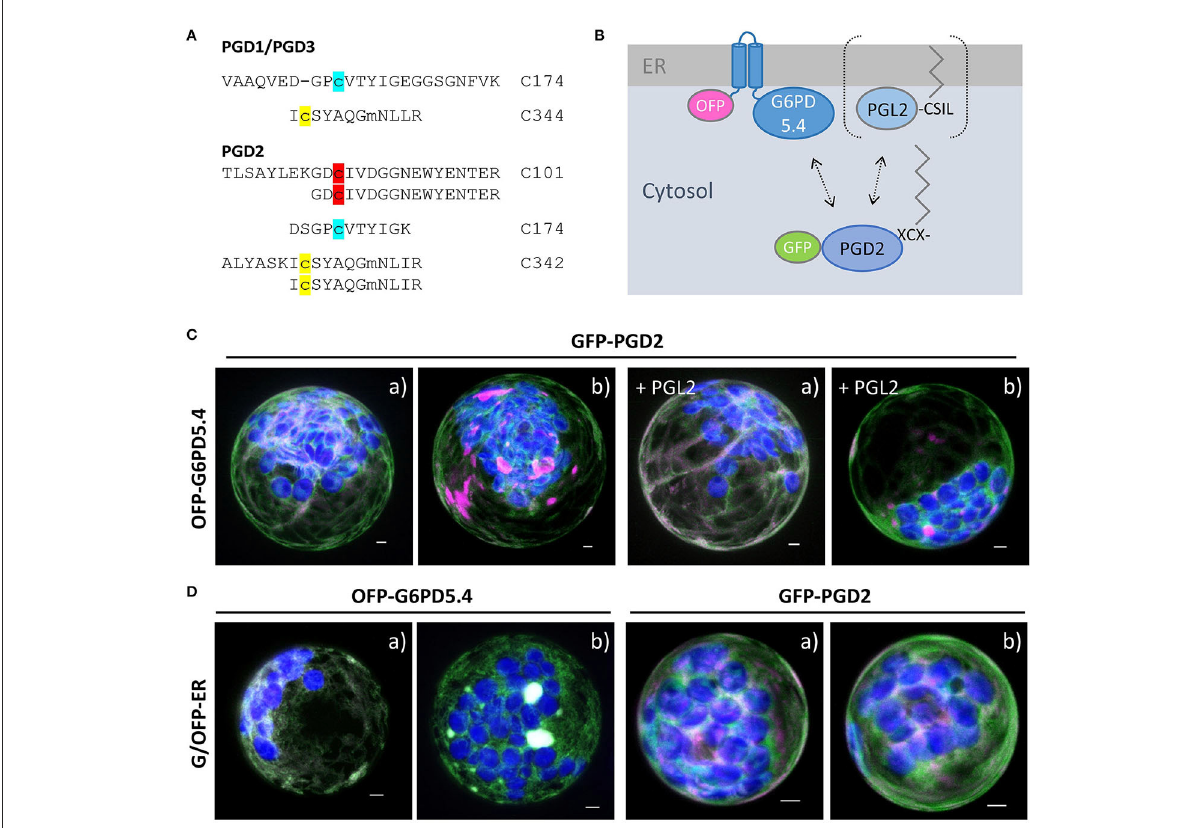
FIGURE7 Co-expression of OFP-G6PD5.4 and GFP-PGD2 without or with PGL2. 6-phosphogluconate dehydrogenase (PGD) is the second OPPP enzyme contributing to NADPH provision. (A) PGD peptides found in an Arabidopsis palmitoylome for PGD1/3 (cannot be discriminated) and PGD2 (Kumar et al., 2020). Cysteine positions shared by all PGD isoforms are labeled in yellow/blue, and the unique one of PGD2 in red. Among reporter fusions of the three PGD isoforms, PGD2 showed weak co-localization with PGL2 at the ER (Supplemental Figure S6). (B) To test whether PGL2 might function as a bridge between the two OPPP dehydrogenases, the GFP reporter was deleted and the resulting expression cassette with “naked” PGL2 was inserted into the OFP-G6PD5.4 construct (Nxn site). (C) Co-expression of GFP-PGD2 with OFP-G6PD5.4 either without or with PGL2 ( + PGL2). (D) OFP-G6PD5.4 or GFP-PGD2 were co-expressed with the luminal ER marker (GFP-ER or OFP-ER) as control. Note that two different patterns (a, b) were observed. The images show maximal projections of about 30 optical sections as a merger of all channels (for single channel images, refer to Supplemental Figure S7). GFP in green, OFP in magenta, and chlorophyll autofluorescence in blue; white signals indicate co-localization of GFP and OFP (or very close signals < 200nm). Scale bars, 3 µ